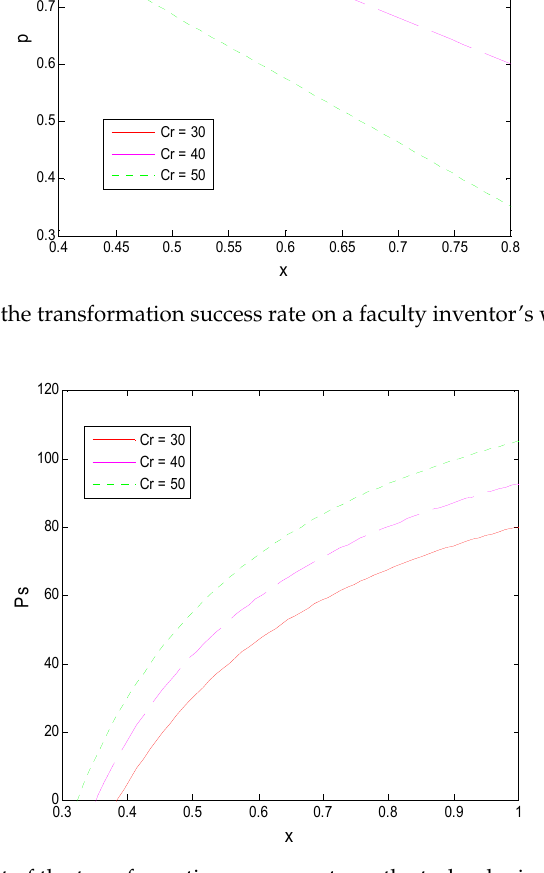
Figure 14. The e ff ect of the transformation success rate on the technological transaction 13. The effect of the Figure 14. The effect of the transformation transformation success rate on a faculty success rate on the technological inventor’s willingness to “comply with transaction price. the rules”.